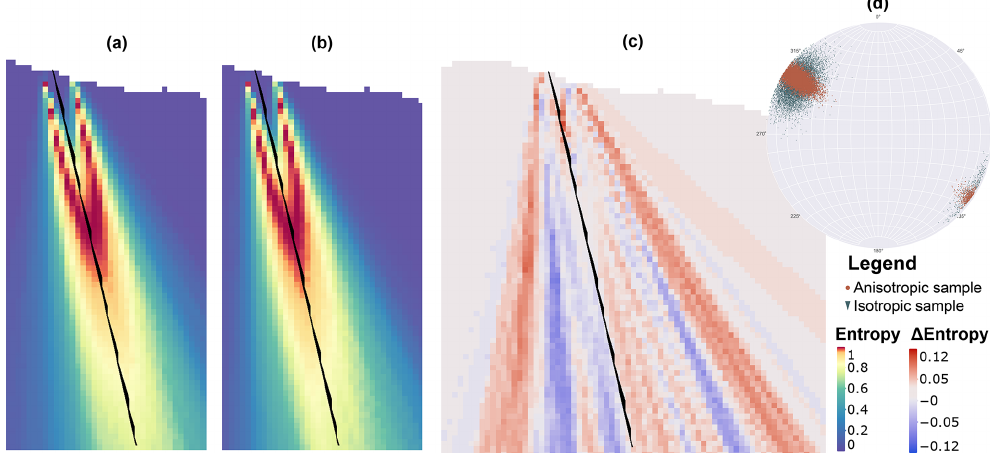
Figure 9. Visual comparison of geologic model entropy generated using (a) anisotropic and (b) isotropic Bingham distributions. The entropy difference between these two models in (c) highlights slight skewing of the uncertainty envelope towards steeper dipping fault zones when parameterized using samples from an isotropic Bingham distribution (d) . Entropy difference is shown such that negative values indicate higher entropy in the isotropic orientation